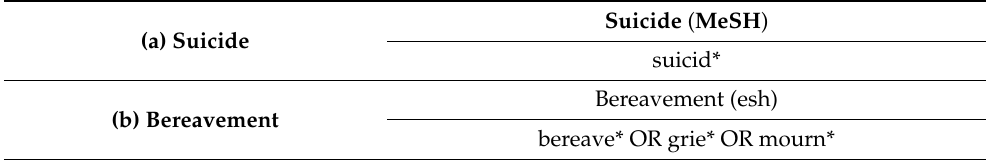
Table 2. Search strategy for concepts: (a) suicide, (b) bereavement and (c) health services. Asterisk (*) used for